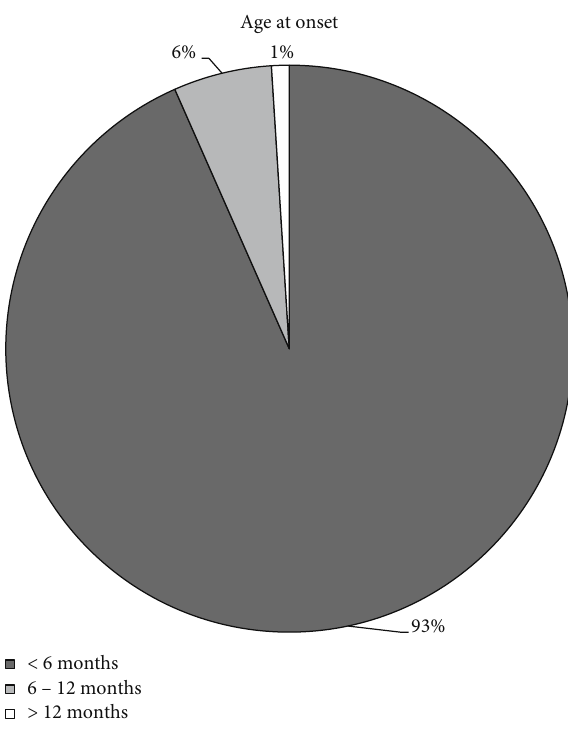
Figure 1: Age at onset in reviewed cases with AADC de fi